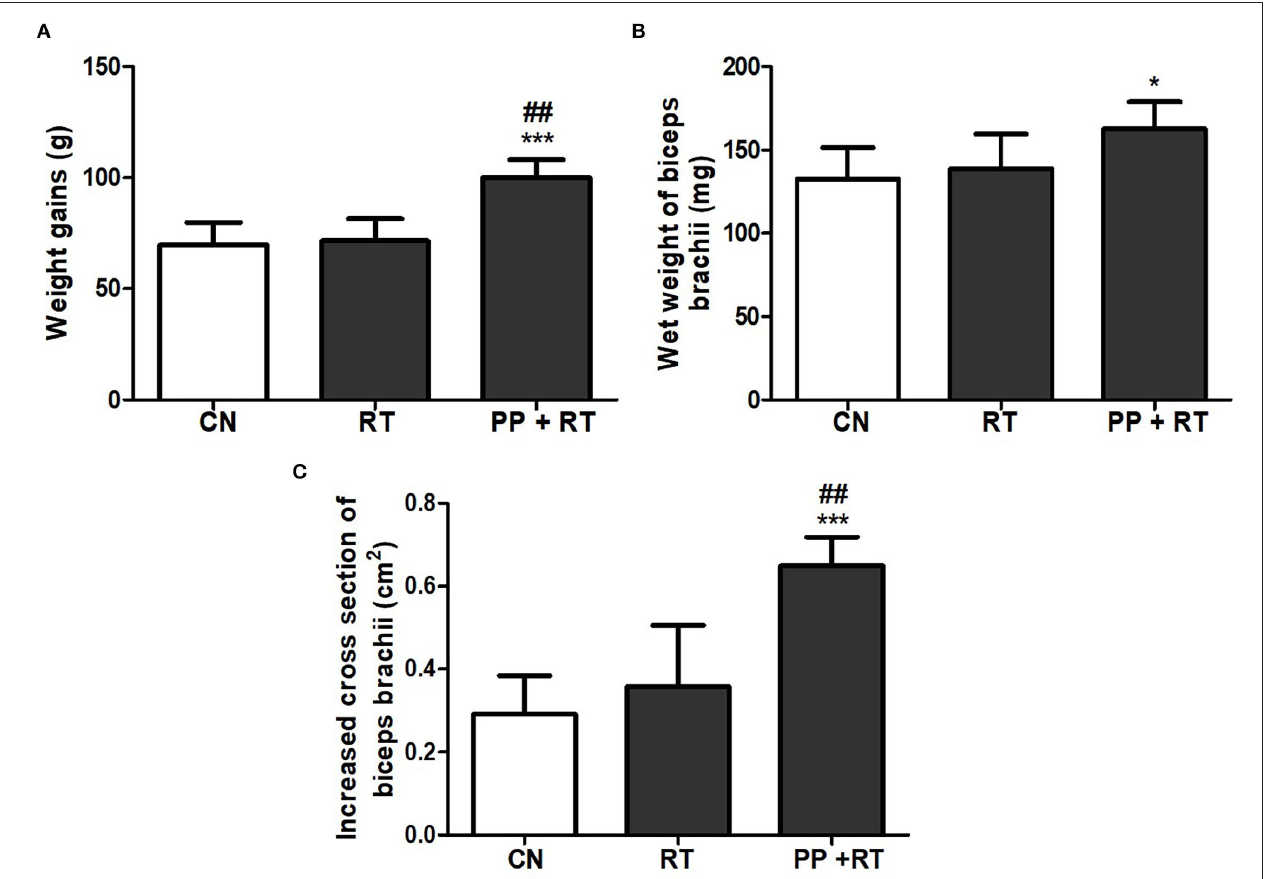
FIGURE 1 | Pea peptide supplementation combined with resistance exercise induced elevated muscle thickness and weight gains. (A) Body weight gains of the rats in CN, RT, and PP + RT group. (B) Wet weight of biceps brachii in the rats of CN, RT, and PP + RT group. (C) Increased cross-section of biceps brachii in the rats of CN, RT, and PP + RT group. CN: Control group, the rats were intragastrically administered with same volume of saline; RT: Resistance training group, the rats were carried out 3 times each week of resistance exercise training; PP + RT: Pea peptide supplementation combined with resistance exercise training group, the rats were daily intragastrically administered with 0.4 g/kg body weight of pea peptides and performed three times each week of resistance exercise training. The significant difference between groups was validated with one-way ANOVA using GraphPad Prism 6, * p < 0.05, *** p < 0.01 vs. CN group, and ## p < 0.01 vs. RT group ( n = 5/group). Data are presented as mean ± standard deviation (M ±